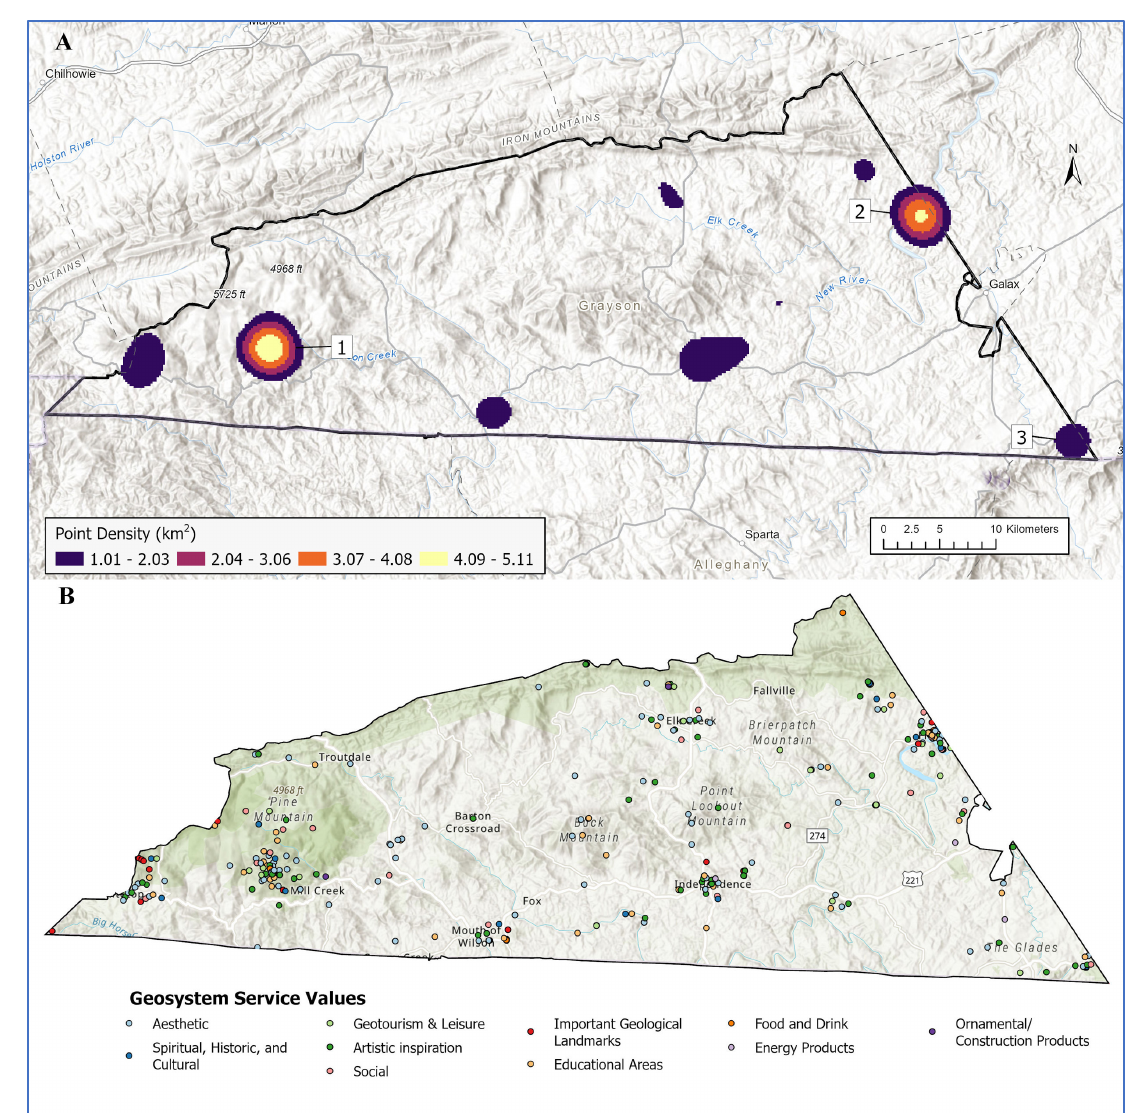
Figure 6. ( A ) Kernel density map of the geosystem services markers based on individual point marker locations. 1. Hotspot situated around Grayson Highlands State Park; 2. Hotspot centered around the town of Fries; 3. Hotspot near Blue Ridge Music Center on the Blue Ridge Parkway. ( B ) Individual point locations for each geosystem service, by category.